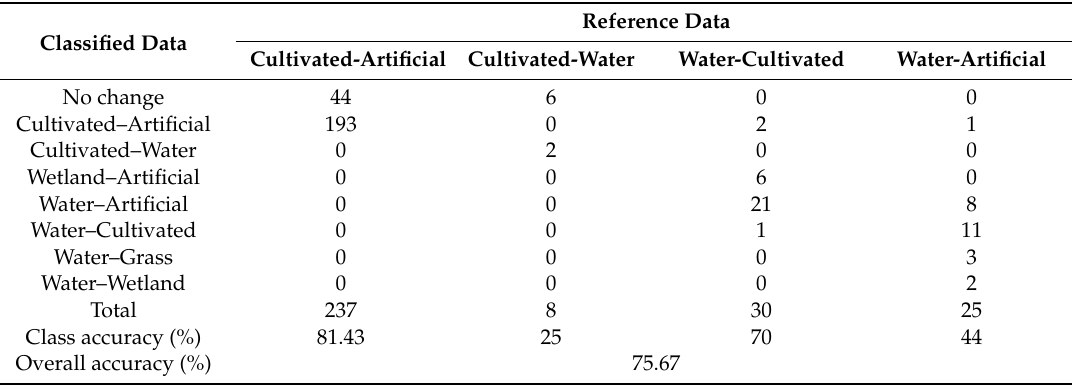
Figure 11. Land cover change map for Shanghai from 2000 to 2011. Table 7. Multiclass change accuracy of the proposed